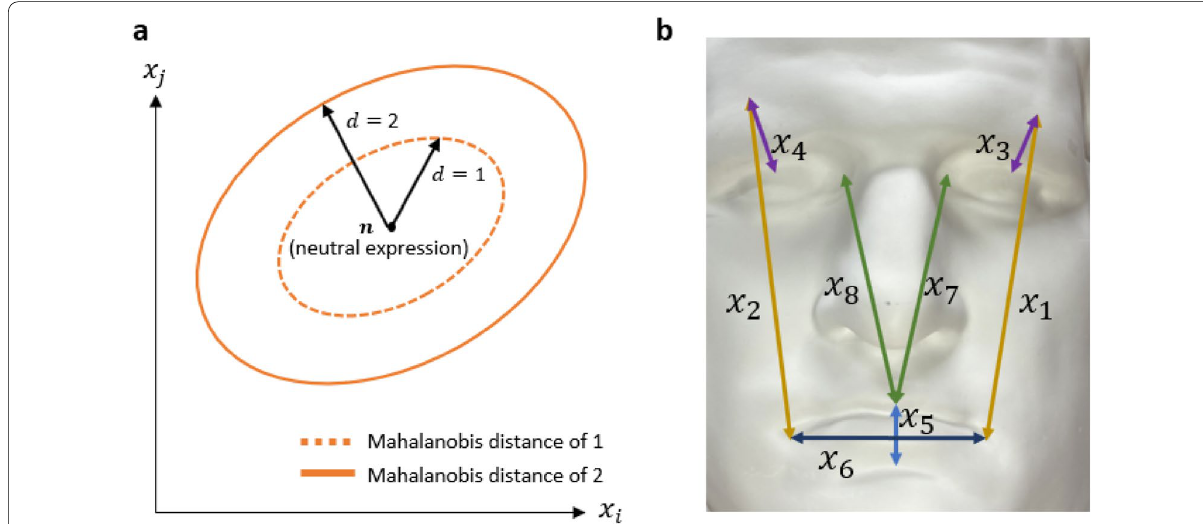
Fig. 4 a Contour lines of theMahalanobis distance in 2D space . b Distance features for pain rating. x 1 , x 2 : from eyebrow to mouth; x 3 , x 4 : from eyebrow to eye; x 5 : mouth height; x 6 : mouth width; x 7 , x 8 : from eye to